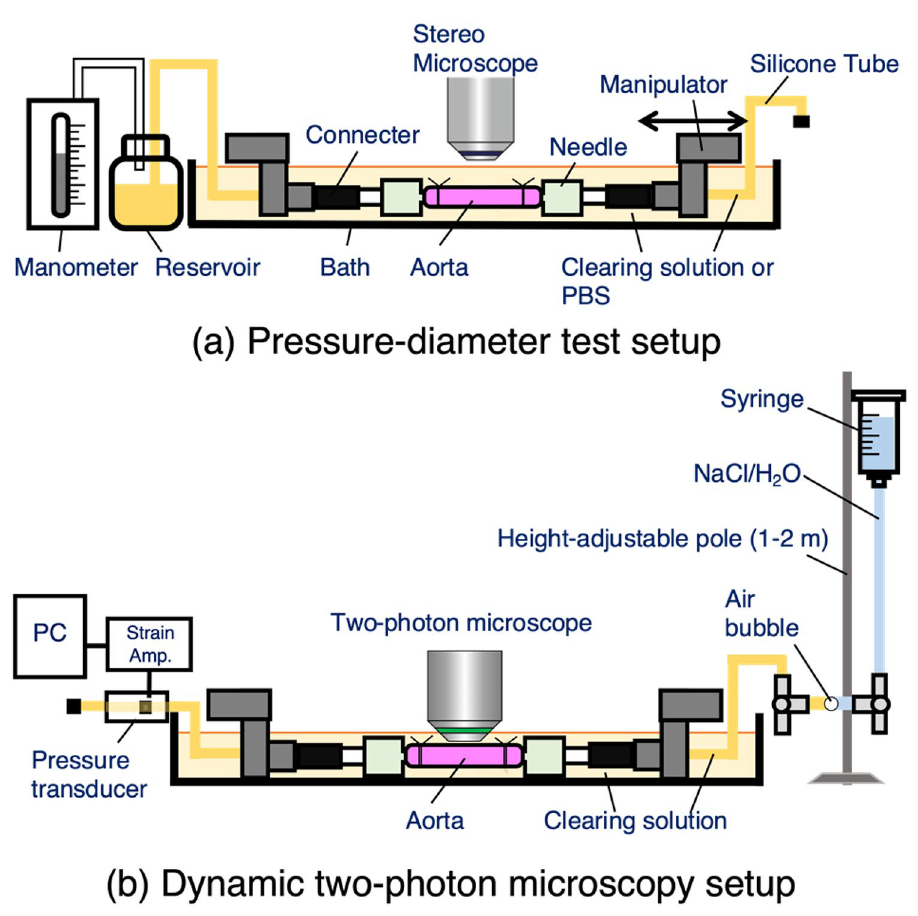
Figure 2. Schematic illustrations of the experimental setup for ( a ) pressure-diameter test and ( b ) dynamic two- photon